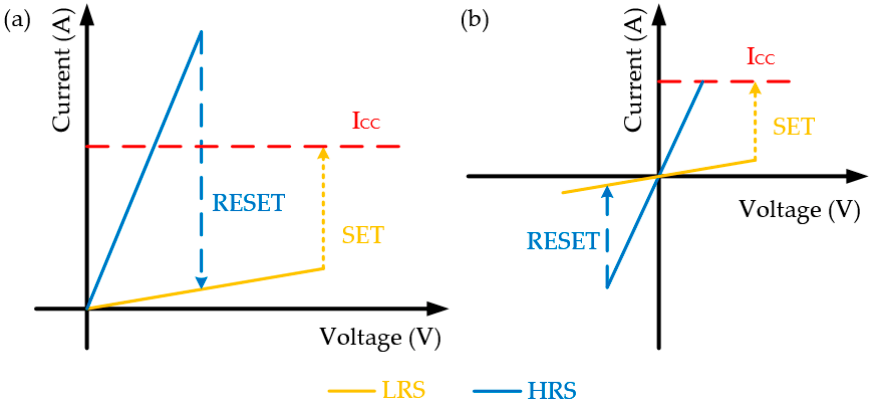
Figure 2. ( a ) Unipolar and ( b ) bipolar Modes for RRAM devices.